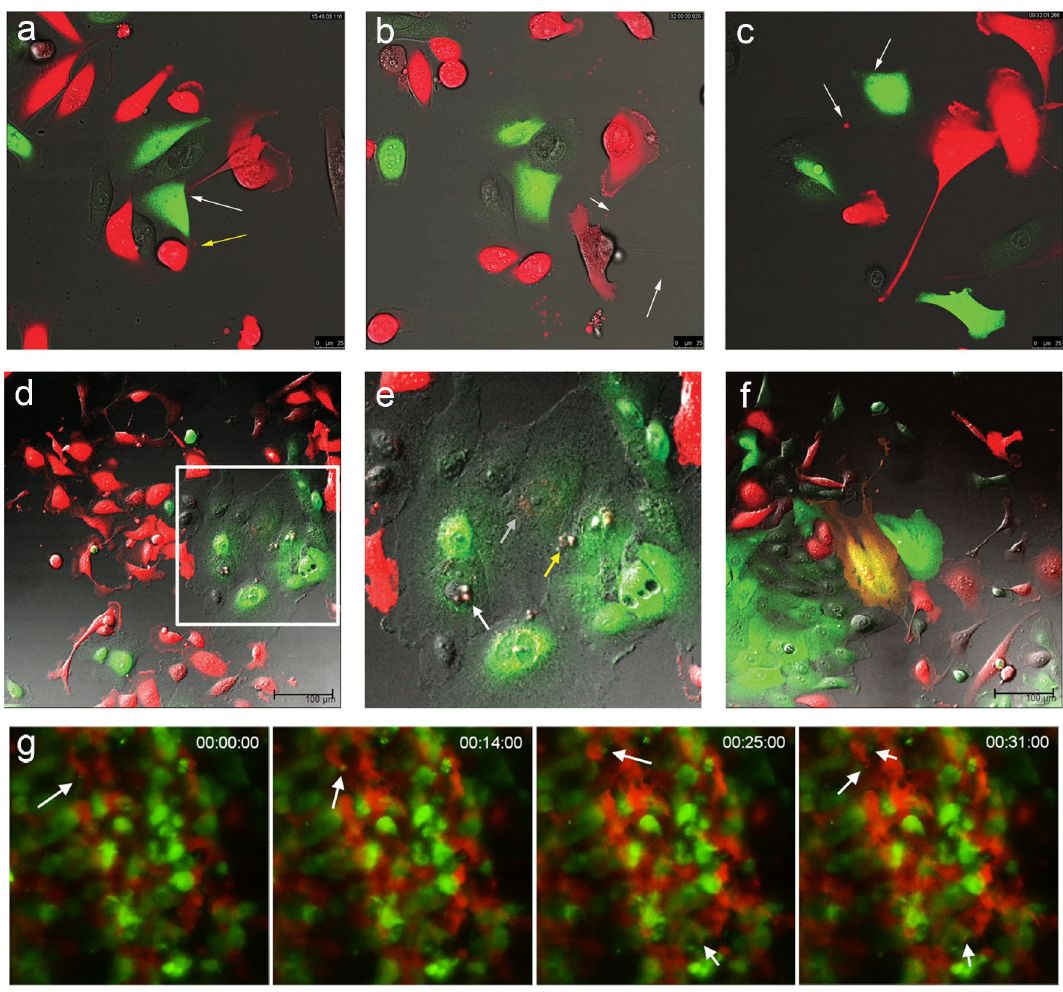
Figure 1. Dynamic cell–cell interactions between breast cancer cells and non-tumorigenic mammary epithelial cells. Representative images of cell–cell interactions between RFP-transfected MDA-MB-231 breast cancer cells and GFP-transfected MCF10A non-tumorigenic mammary epithelial cells were captured using time-lapse confocal microscopy ( a – d ). ( a ) MDA-MB-231 cells use lamellipodia-like structures to contacting MCF10A cells (yellow arrow) or distant MCF10A cells (white arrow). ( b ) Nanotube-like structures extending from MDA-MB-231 cells are seen (white arrows). ( c ) RFP-expressing vesicles from MDA-MB-231 cells are transferred to MCF10A cells (white arrows). ( d , e ) The area within the white rectangle in ( d ) is shown in ( e ). Transferred vesicles from MDA-MB-231 cells are located in both nucleus (white arrow) and cytoplasm (yellow arrow) of MCF10A cells. ( f ) A minority of co-cultured cells show dual fluorescence. ( g ) The representative images of the in vivo behavior of MDA-MB-231 cells and MCF10A cells co-injected in the earlobe of mouse are shown with migrating extracellular vesicles (white